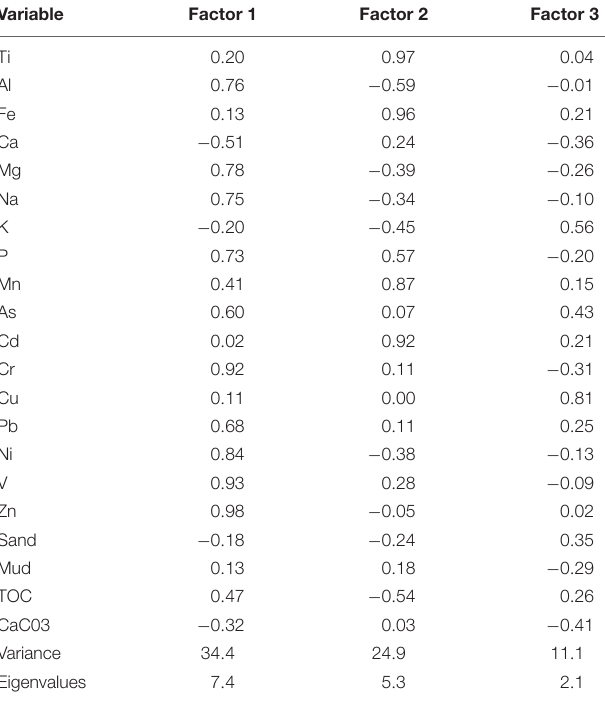
TABLE 6 | Varimax rotated factor matrix for surface sediments geochemical data from the Gulf of